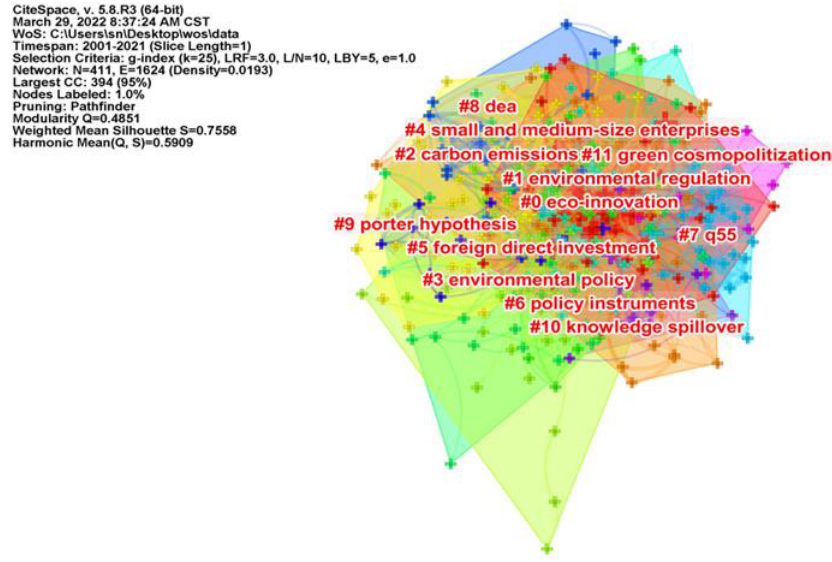
Figure 9. CiteSpace-based keyword clustering mapping.